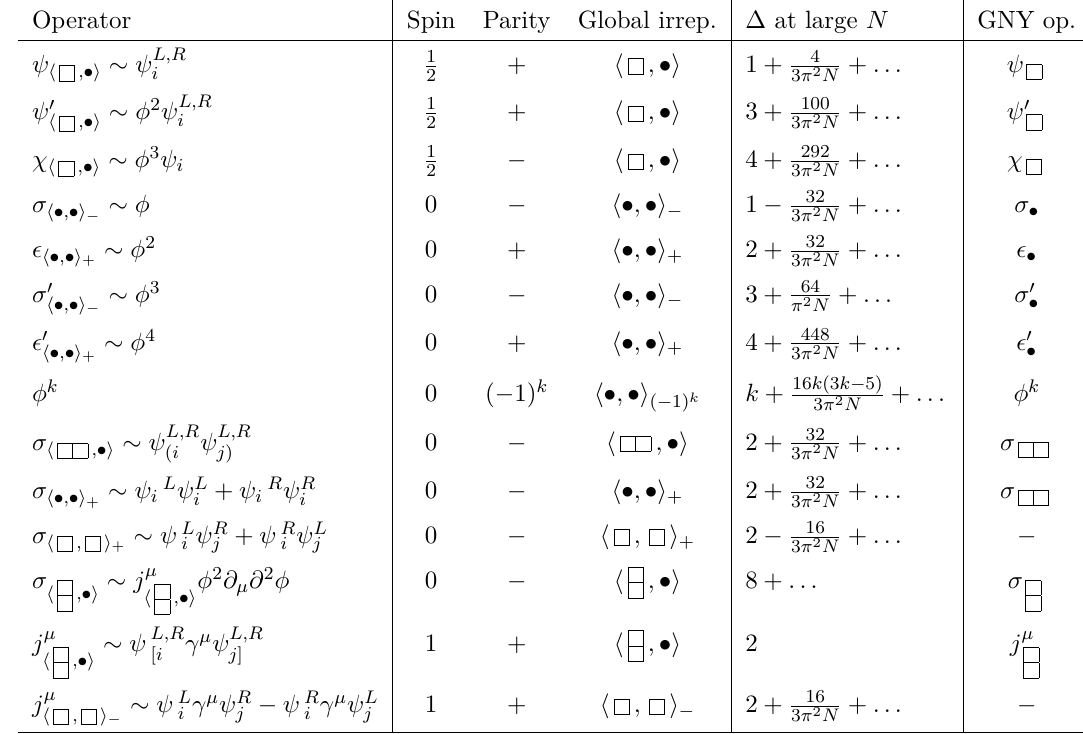
Table 6 . Estimates for the large- N scaling dimensions at the O ( N/ 2) 2 oZ 2 GNY critical point. The last column shows which scaling dimensions in the O ( N ) GNY critical point match the dimensions of some operator in the O ( N/ 2) 2 o Z GNY critical point at low orders in the large- N expansion. 2